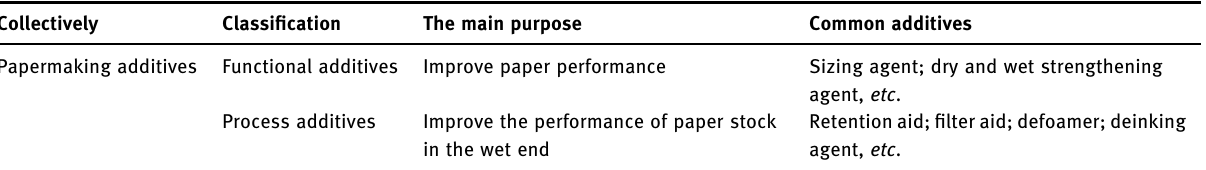
Table 2: Classi fi cation of papermaking auxiliaries